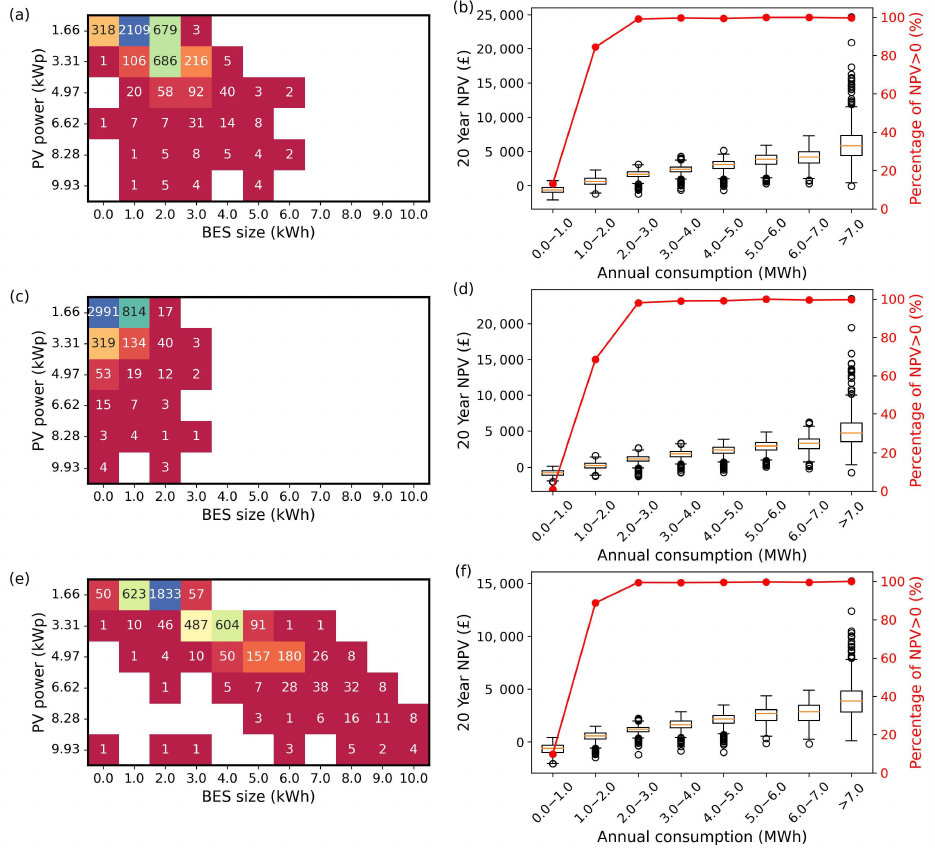
Figure 9. Future costs scenario results. ( a ) Optimum PV and battery sizes for the future Agile tariff. ( b ) NPV of optimum PV + BES system by consumption for future Agile tariff. ( c ) Optimum PV and battery sizes for the future Std tariff. ( d ) NPV of optimum PV + BES system by consumption for future Std tariff. ( e ) Optimum PV and battery sizes for the future ToU tariff. ( f ) NPV of optimum PV + BES system by consumption for future ToU tariff.